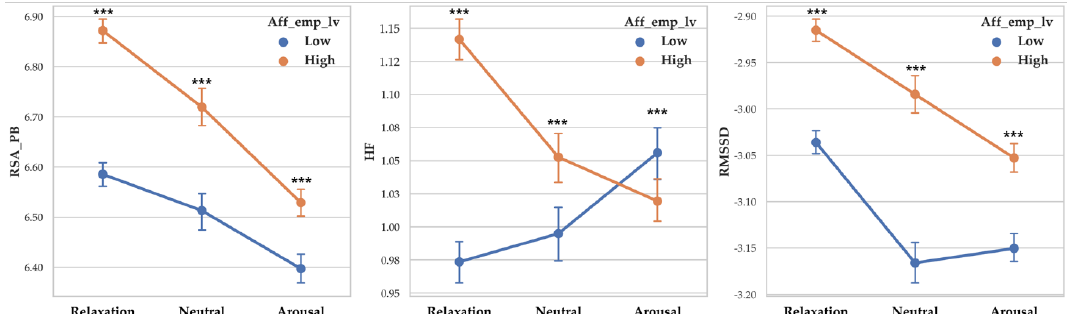
Figure 7. Point graph of vagal response depending on affective empathy level when participant empathized with arousal levels. Aff_emp_lv refers to affective empathy level. Point means mean of vagal responses and error bars represent confidence interval. Asterisk means significant vagal responses difference according to affective empathy level. (***: p < 0.001).